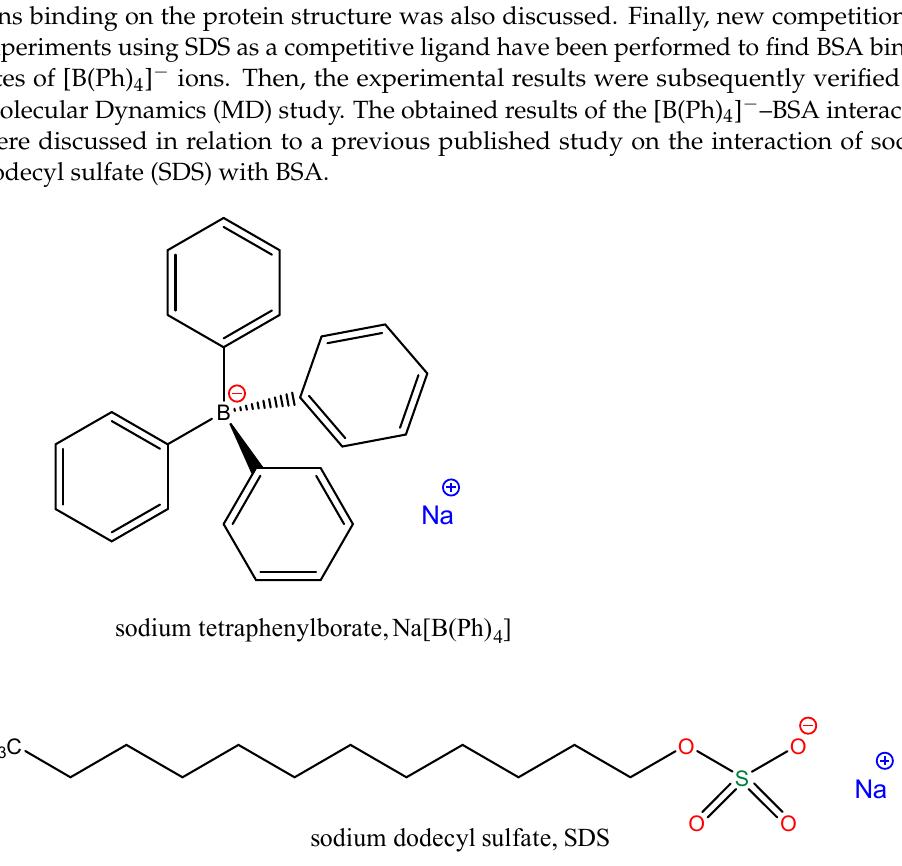
Figure 2. Chemical structure of sodium tetraphenylborate (Na[B(Ph) 4 ]) and sodium dodecyl sulfate (SDS).